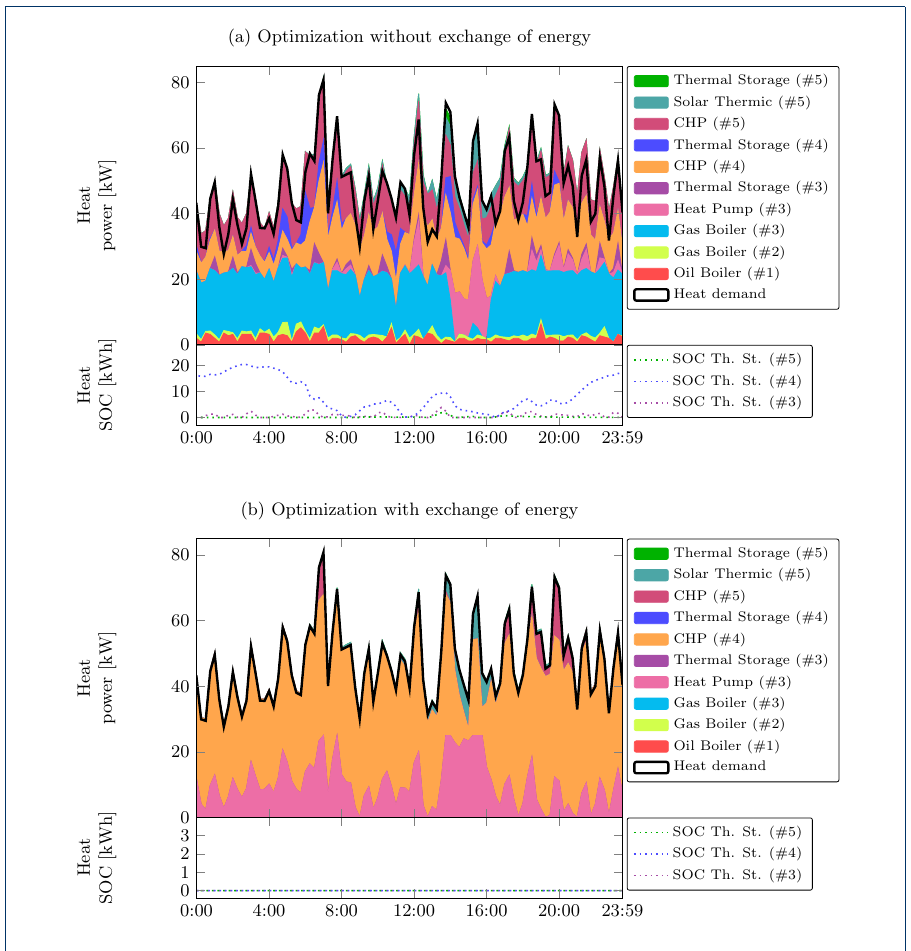
Figure 1 Comparison of the reference scenario (a) without exchange of energy and our system (b) with exchange of energy, 1h prediction horizon, (cid:12)xed electricity